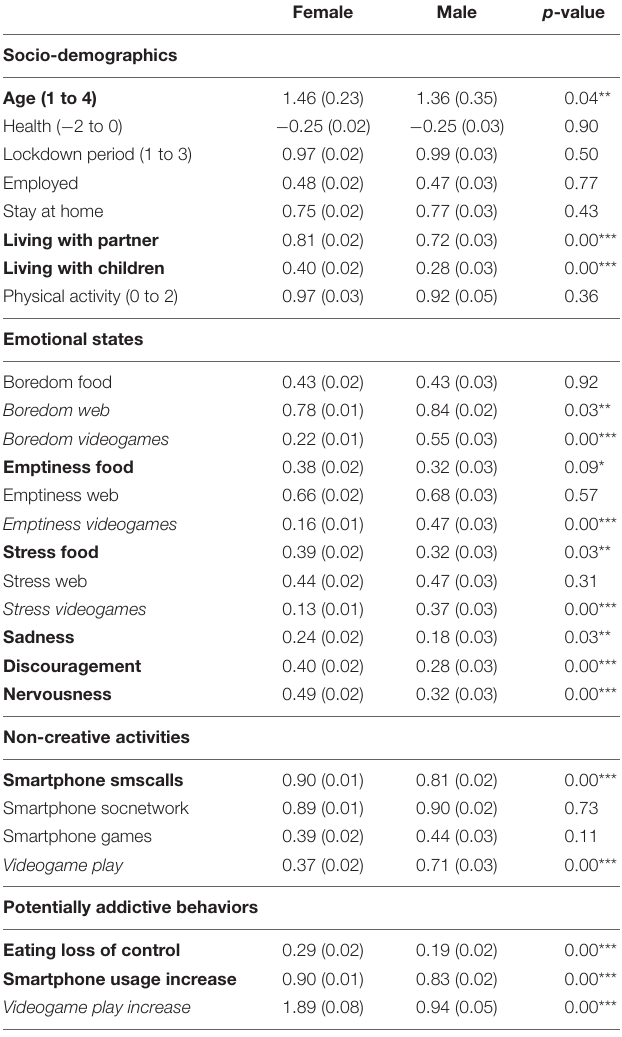
TABLE 2 | Gender differences in idiosyncratic features, emotional states, and